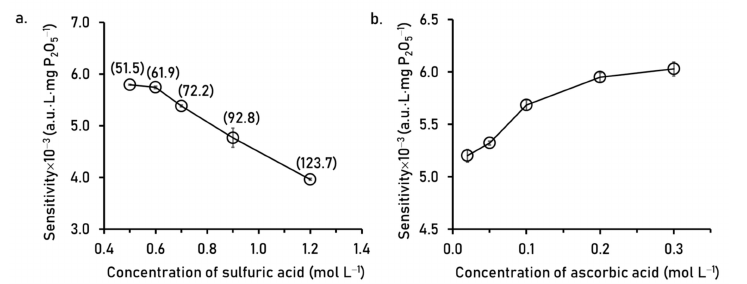
Figure 5. Effect of concentrations of ( a ) sulfuric acid in R1 and ( b ) ascorbic acid in R2 on the sensitivity for phosphate analysis. The numbers in parenthesis are the ratio of [H + ]:[MoO 42 −